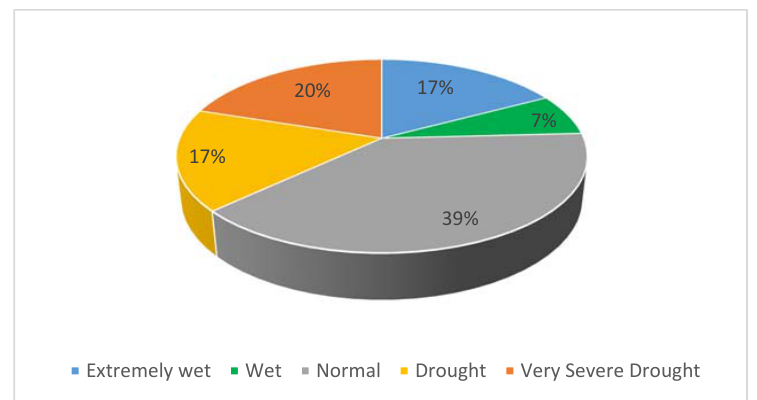
Figure 7. Distribution of SIAP values into classes (station 2). Table 4. Summary of drought classifications for station 2.